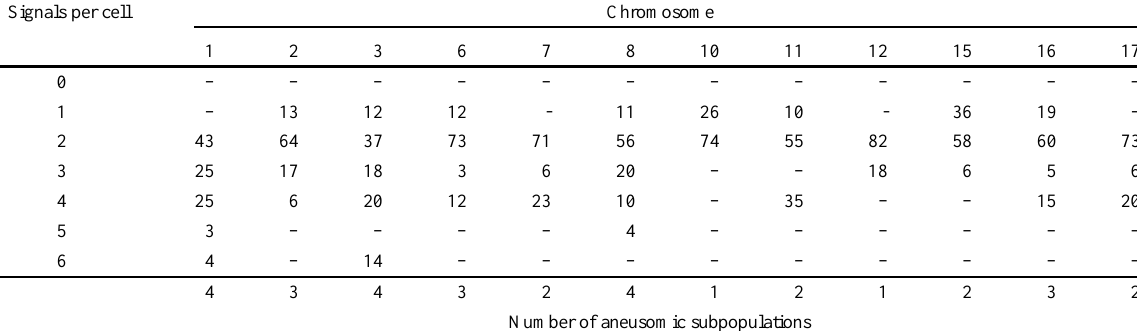
Results of FISH with chromosome-specific DNA probes for an aneuploid carcinoma with a DNA index of 1.9 (case